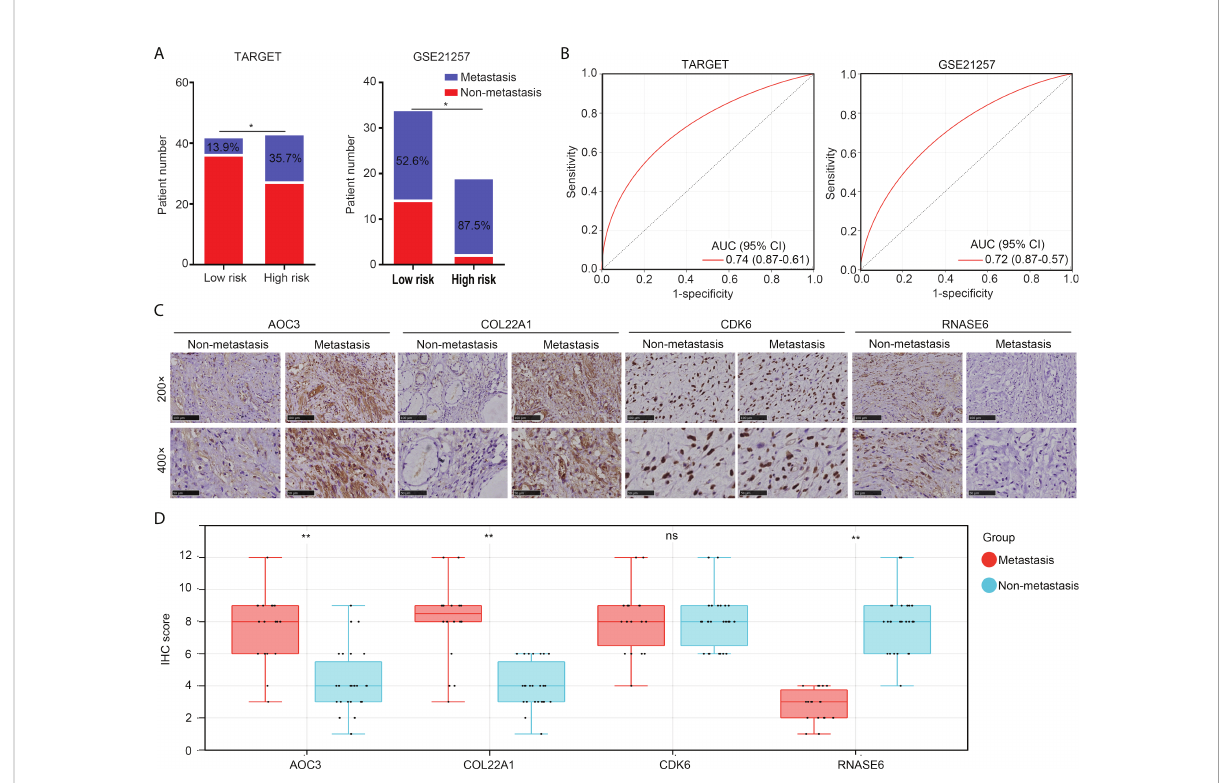
FIGURE 6 The risk model has the potential to predict metastasis in patients with OS. (A) Non-metastasis and metastasis cases between low- and high-risk group OS tissues in the TARGET and GSE21257 cohorts. (B) ROC analysis for the diagnostic value of the risk model in the prediction of OS tissue metastasis. (C, D) IHC was performed to detect the expression of COL22A1, CDK6, RNASE6 and AOC3 in non-metastasis and metastasis OS tissues (magni fi cation 200× and 400×). *p < 0.05; **p < 0.01; ns, no signi fi cant.